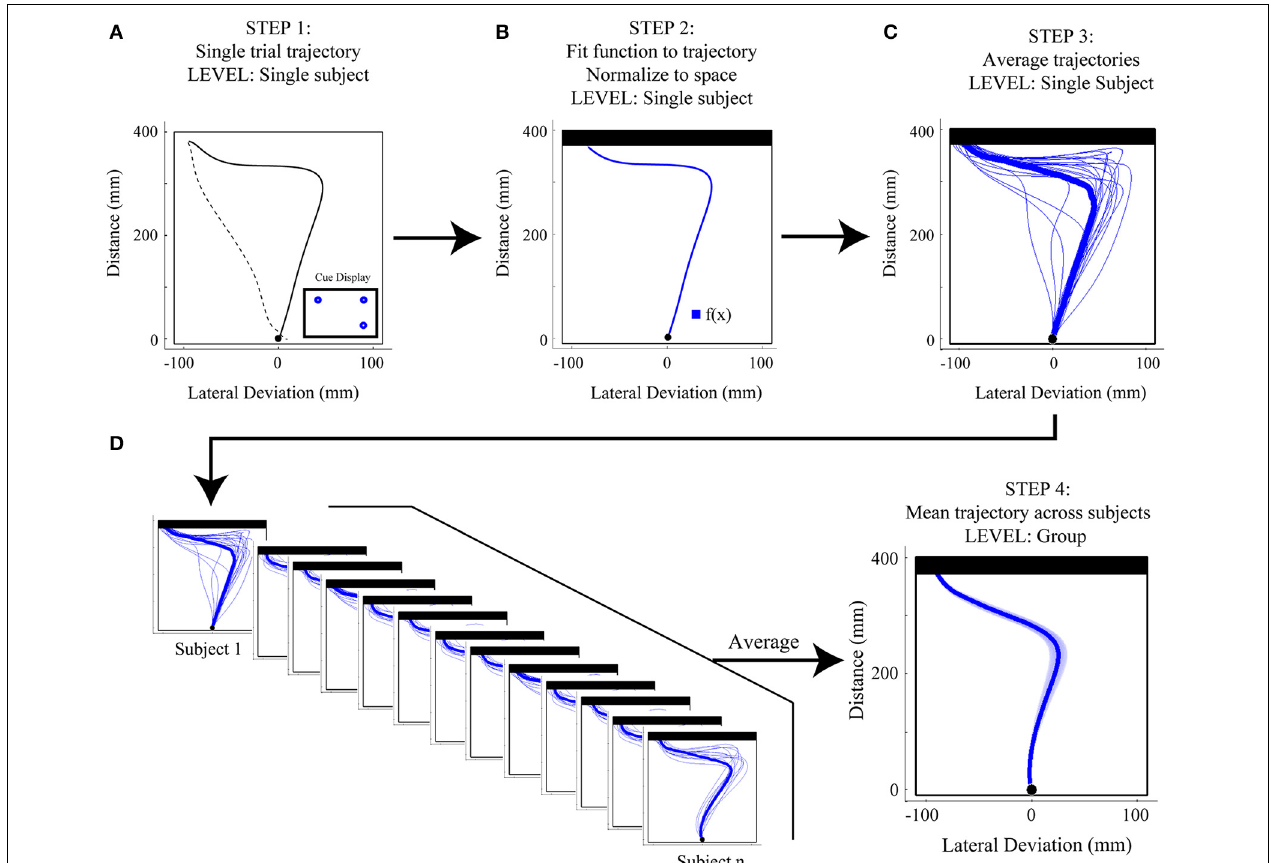
FIGURE 3 | Step-by-step overview of Functional Data Analysis (FDA) methods. (A) Step 1: Single trial reach trajectories are extracted for a particular experimental condition [in the case here, a 1(high)v2 target display with the target on the left cued]. The full trajectory is denoted by a dashed black line and includes the hand returning to the start position, while the extracted reach is denoted by a thicker solid black line and includes only the movement of interest, from start position to touch screen. (B) Step 2: The single trial reach trajectory is then fit with a mathematical function [f(x)] and is then normalized to space (in the case here, with respect to touchscreen